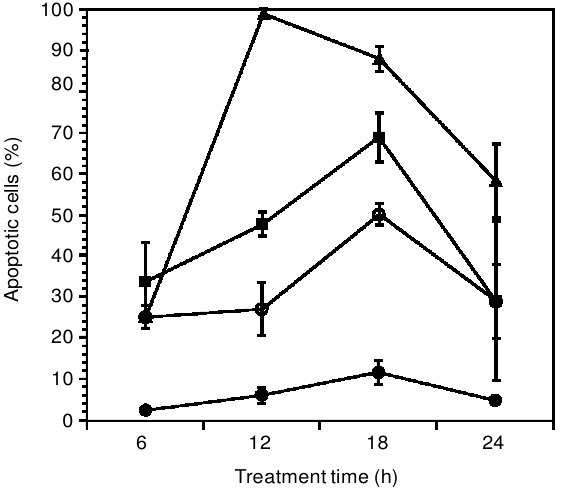
FIG. 3. Apoptosis caused by NF- k B inhibitors as a function of time. RAW 264.7 cells were incubated for 6, 12, 18 and 24 h with no treatment ( d ), 100 m M PDTC ( s ), 50 m M TPCK ( j ) or 10 m M calpain 1 inhibitor ( m ). The percentage of cells undergoing apoptosis was assessed by acridine orange staining and is shown on the ordinate. Error bars represent SEM. Each experiment was repeated at least three times.